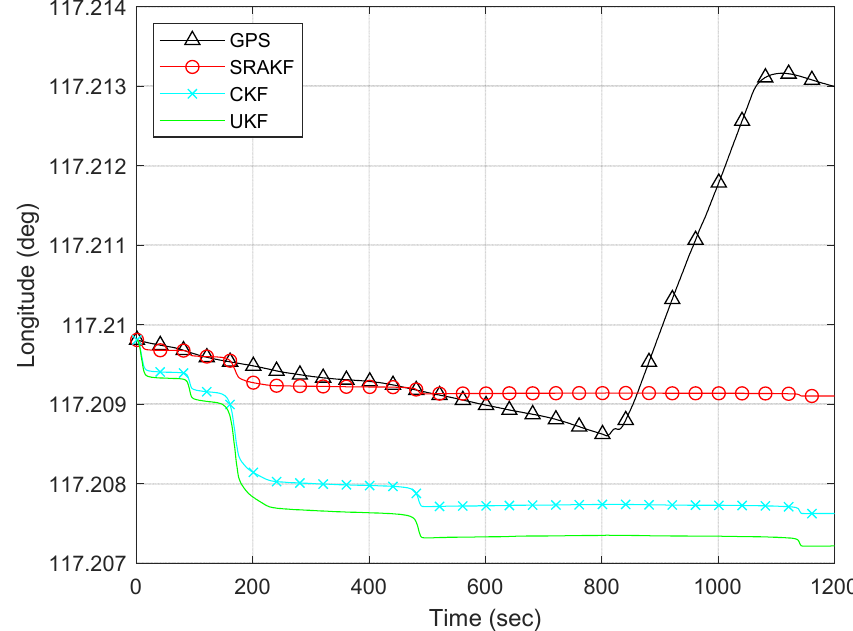
Figure 8. Longitude positions for the surface lake trial.